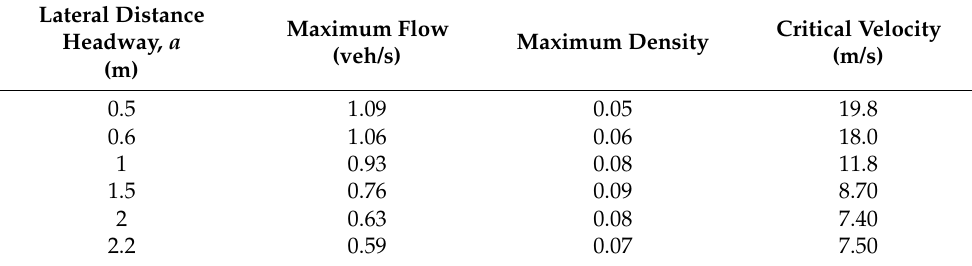
Table 4. Maximum flow, density, and critical velocity for the proposed